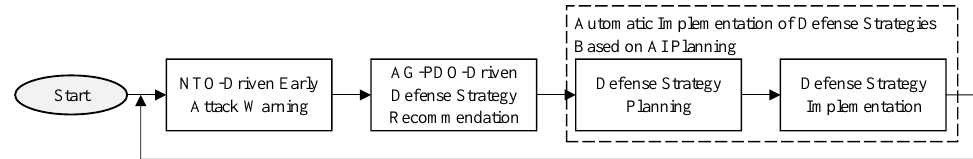
Figure 1. The overall design of the security